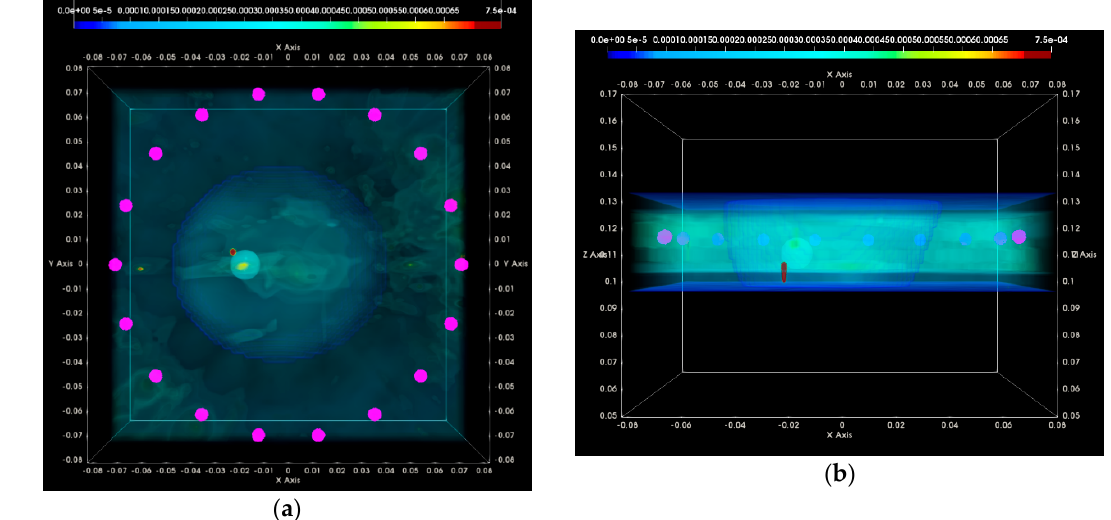
Figure 26. Breast rotational position #2—Test Date 1—image formed using six vertical positions of the sensor network, in the vicinity of the tumor—image in the interior of the breast superimposed with the image of the full imaging domain: ( a ) top XY view; ( b ) side XZ view.